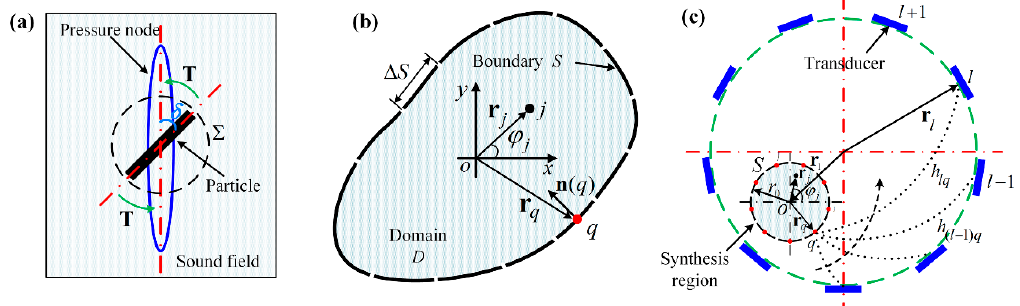
Figure 1. ( a ) The acoustic radiation torque on an asymmetric particle in the acoustic field is dependent on the angular position σ ; ( b ) The geometric parameter definitions for discretized Kirchhoff–Helmholtz integral equation within an arbitrary shaped 2D domain; ( c ) The principles of sound field synthesis technique. Multi plane wave transducers are homogenously mounted on a circular and the desired acoustic field is synthesized within the range S .